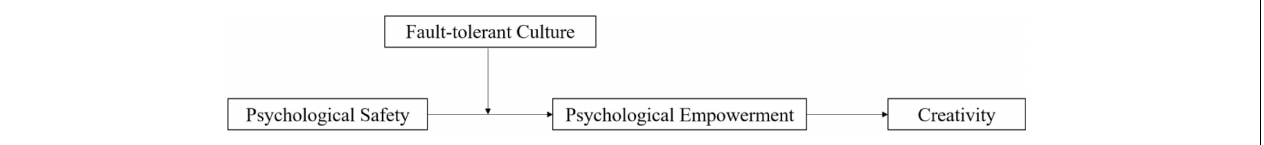
FIGURE 1 | Theoretical framework. Source: Authors build this model based on relevant data.